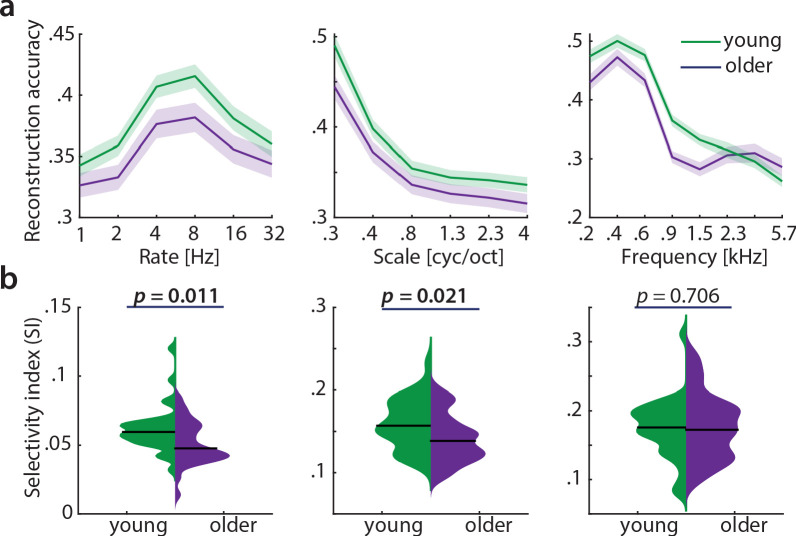
Decoding from auditory cortex with ICA(AROMA)-cleaned data.(a) Mean ± SEM of the MTFs’ marginal profiles for rate, scale and frequency for young (green) and older (violet) participants separately. (b) The selectivity index SI (see Equation 7) was compared per acoustic dimension between age groups using an exact permutation test. Note that irrespective of preprocessing (with or without ICA-cleaning, Figure 5), reconstruction accuracies peak at temporal rates of 4–8 Hz. Likewise, for AROMA-cleaned data SI for temporal rates is higher in young compared to older participants. Removing the young-subject outlier for rate SI (exceeding the grand average by ±2 SD) does not alter the SI mean age difference qualitatively (p=0.027).